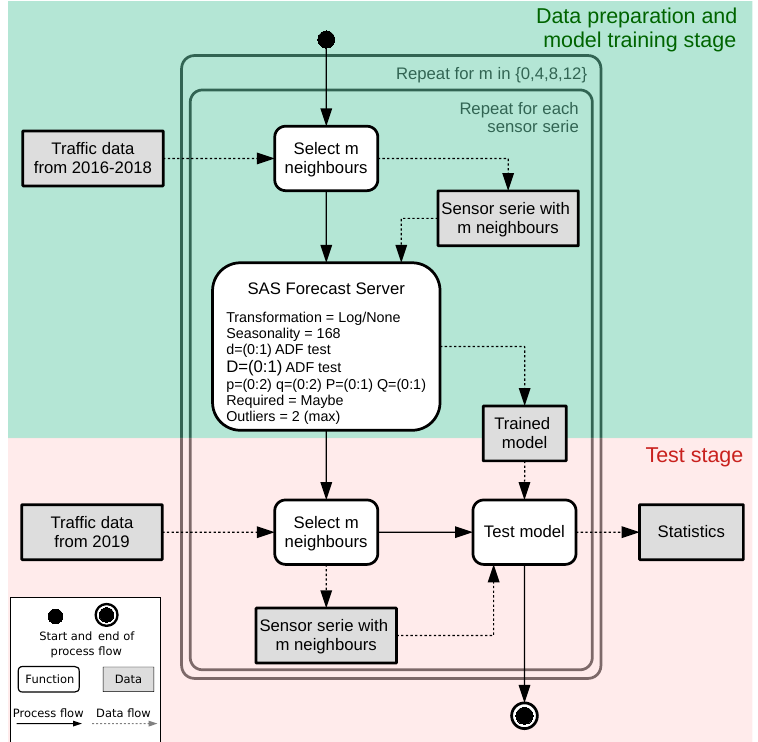
Figure 2. UML activity diagram of the process used to train and test the ARIMA